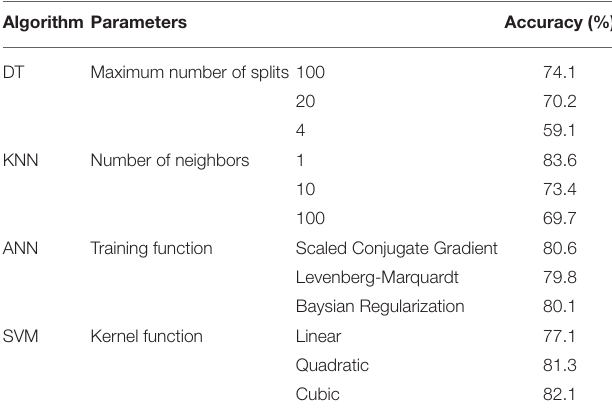
TABLE 2 | Accuracy of different ML algorithms with different